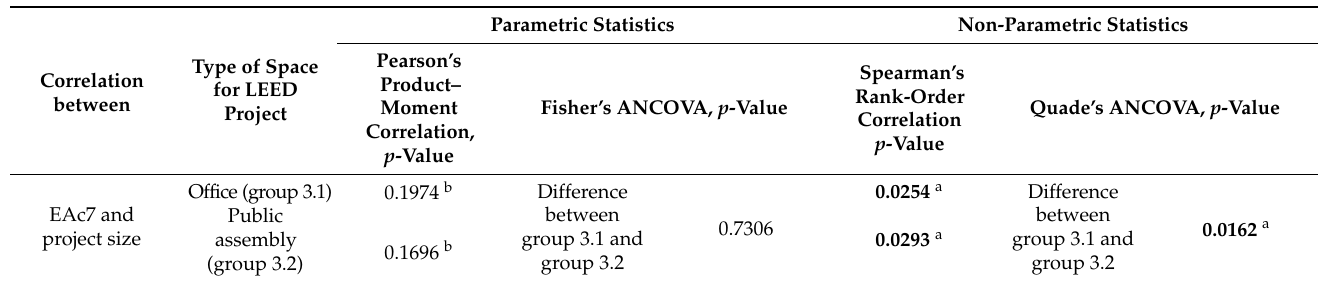
Table 8. Case 3: comparison of EAc7 (Optimize Energy Performance) credit achievement of groups 3.1 and 3.2 considering project size in LEED-NC v4 silver